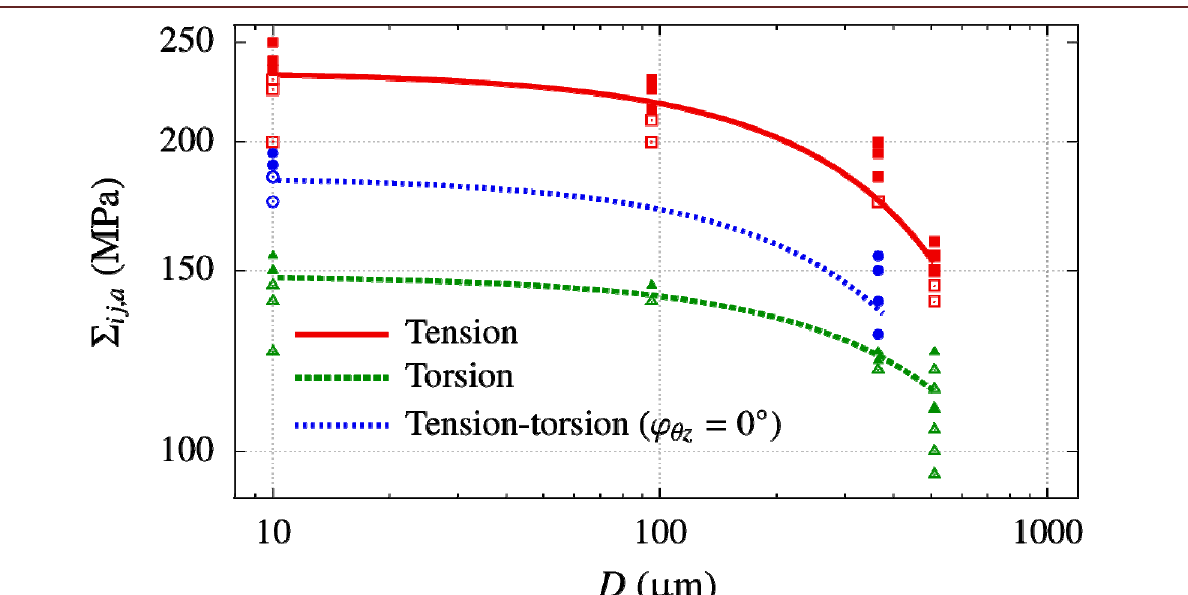
Figure 2: Results of the fatigue tests conducted on the 316L steel in uniaxial tension, torsion and combined tension and torsion (with a biaxiality ratio k  z =0.5) with a load ratio R=-1 as a function of the defect diameter